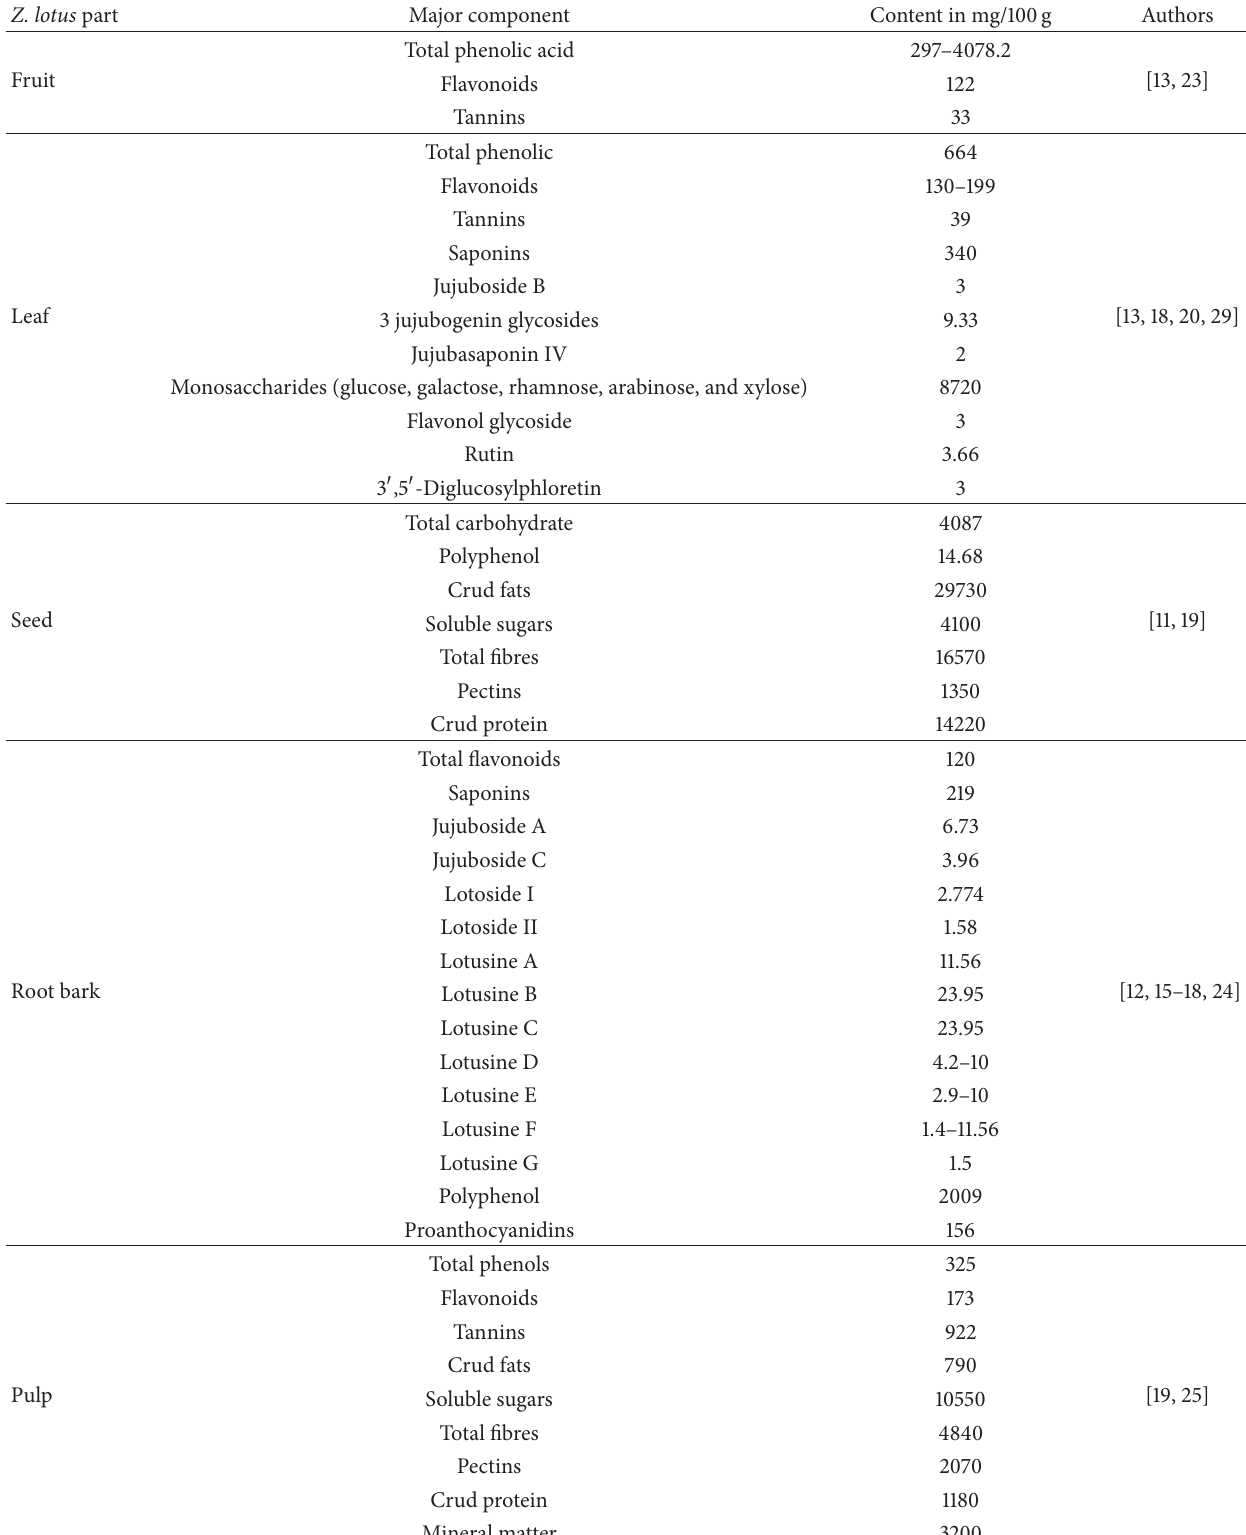
Table 1: Distribution and contents of major bioactive compounds including phenols, flavonoids, alkaloids, saponins, and other phytochemicals in the various parts of Z. lotus